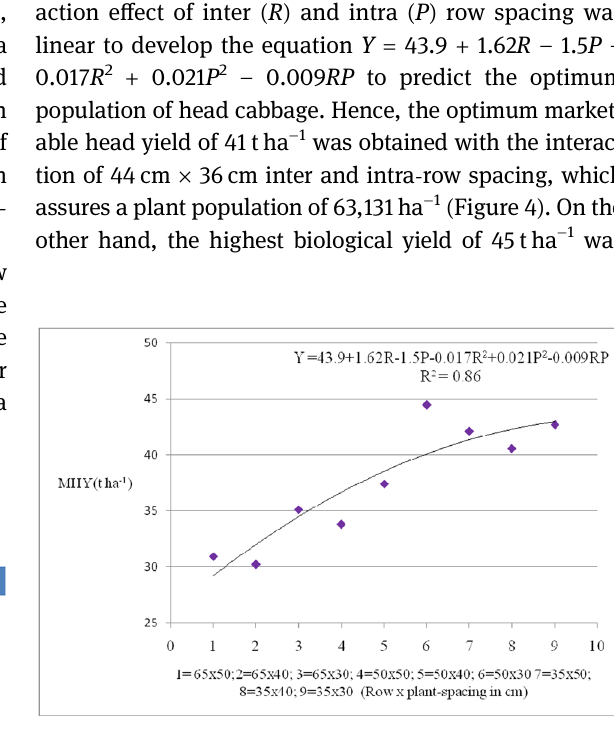
Figure 4: Second - order polynomial curve fi t and regression equation to determine optimum plant population for the head yield of cab - bage, where Y is the marketable head yield ( MHY ) , R is the inter - row spacing, and P is the intra - row